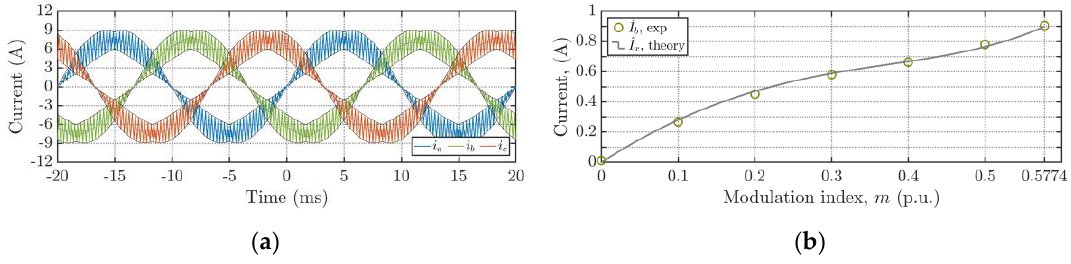
Figure 42. ( a ) Phase currents with primary (black) and secondary (gray) envelopes in case of DPWM3 ( m = 1/√3); ( b ) Phase current ripple rms in case of DPWM3.